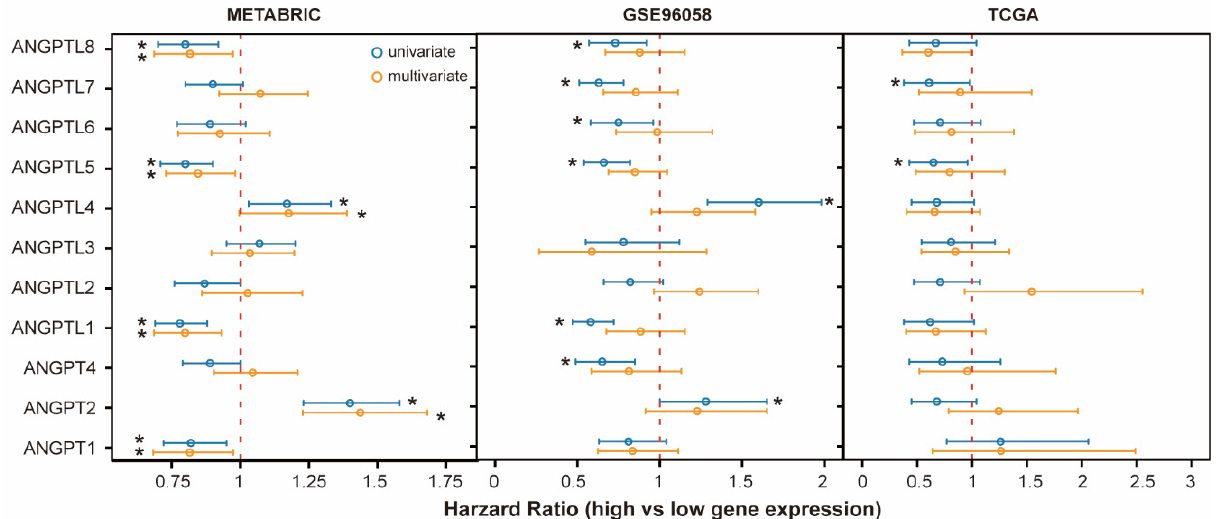
Figure 6. Association between ANGPT / ANGPTL genes and OS in different datasets. Open circles indicate hazard ratio (HR) and bars represent 95% confidence interval (CI) of HR. * Indicates p < 0.05. HR, 95% CI, with p -values obtained from univariate Cox regression analysis (blue circles and bars) or multivariate Cox regression analysis including clinical factors (age, tumor size, stage, and ER and PR status) and molecular subtypes (yellow circles and bars).